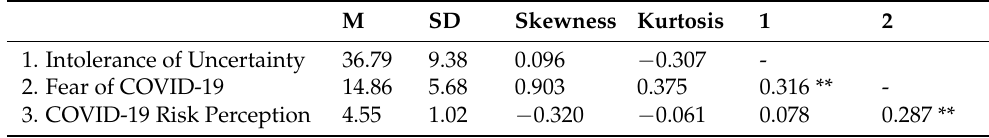
Table 2. Descriptive Statistics and Correlations Between the Variables of the Study.